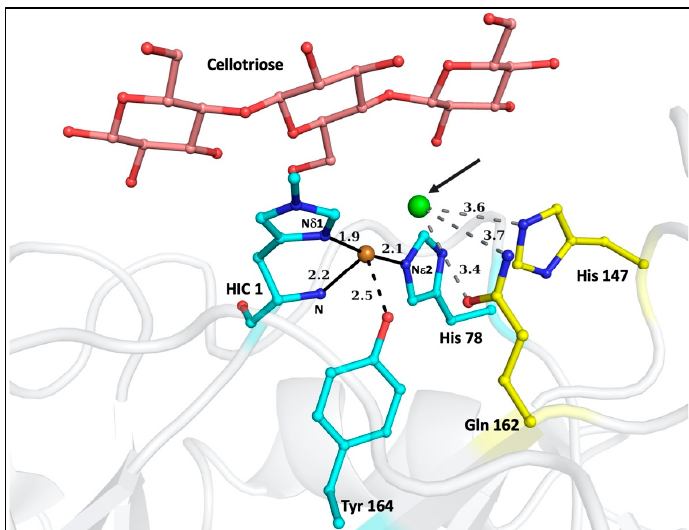
Figure 1. Structure of Lentinus similis AA9A ( Ls AA9A), PDB ID: 5ACF showing its active site with the bound oligosaccharide cellotriose. The 1st coordination sphere of the copper (orange sphere) is formed by the residues His1, His78, and Tyr 164 (colored in cyan). The coordination distances are shown in Å. As the oligosaccharide is bound, the axial water is displaced in this structure, but is visible in Figure 4. At the equatorial position, chloride (green sphere) is bound instead of water. This position (pointed with a black arrow) is the presumed binding site for the activated oxygen species. The 2nd coordination sphere residues are His147 and Gln162 (colored in yellow). His147 is conserved across all AA9 LPMOs. The distances from His147 and Gln162 to the chloride in Å are shown in grey. The residues are represented in ball and stick representation. The figure was prepared in Pymol.